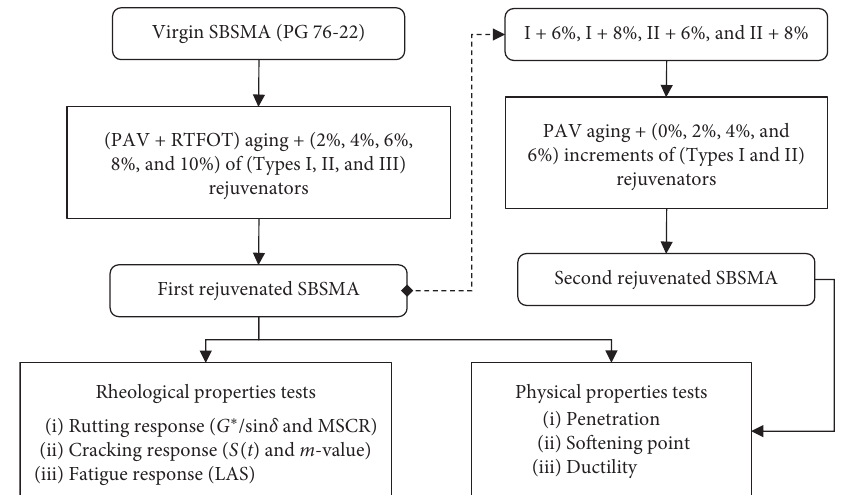
Figure 2: Flowchart of experimental plan.